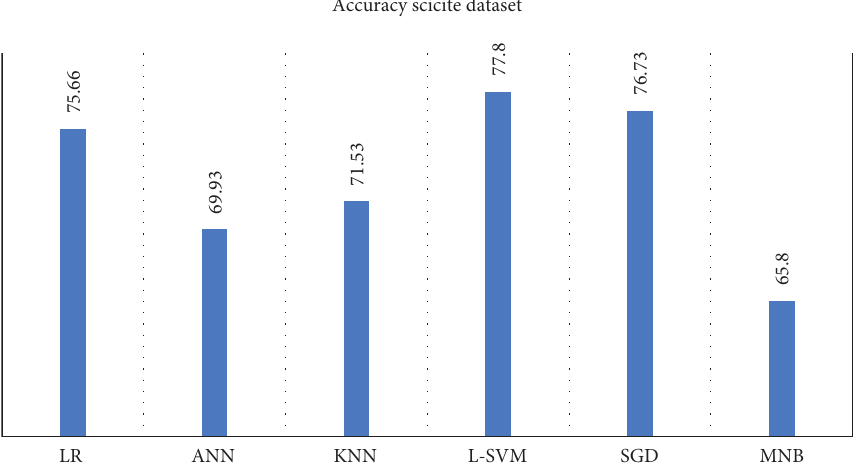
Figure 7: Accuracy of classifiers using the SciCite